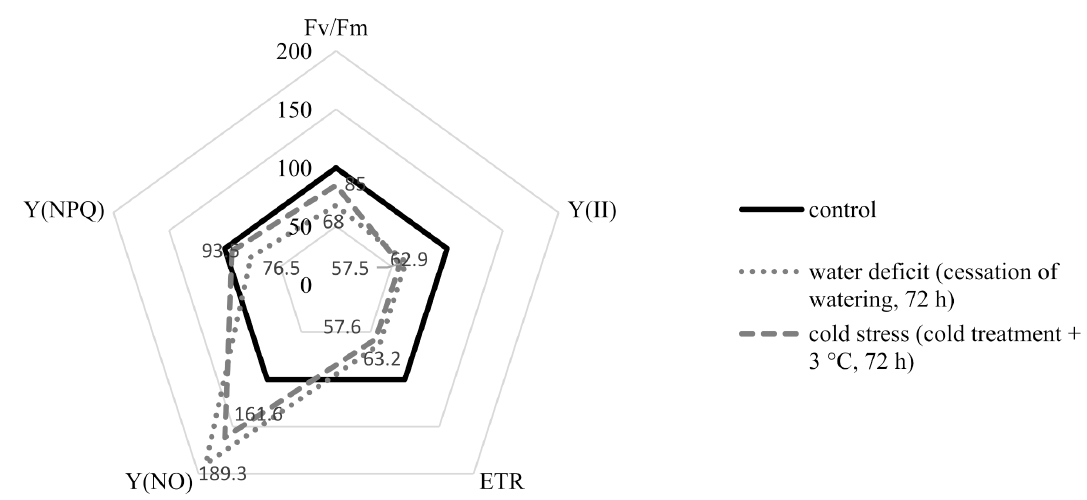
Figure 2. Changes in the activity of the photosynthetic apparatus of R. semenowii under stress conditions.